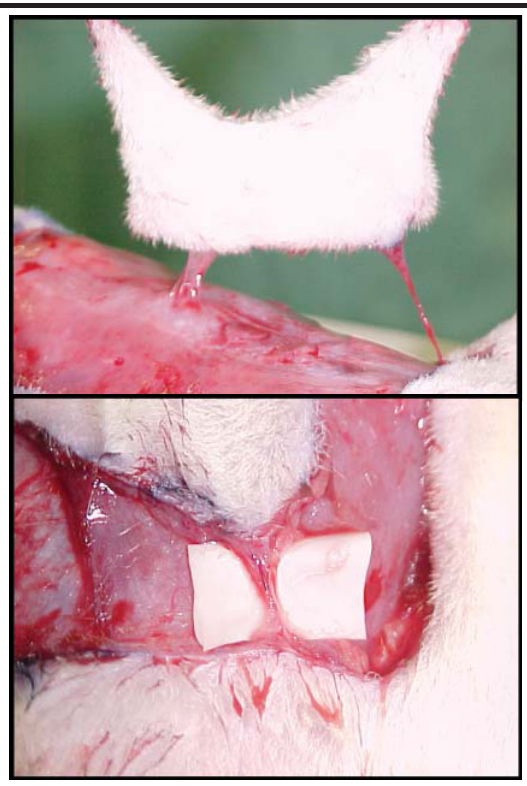
FIGURE 4 - Zone demarcation over the fl ap. Zone I, over the vascular pedicle; Zone II, lateral to midline; Zone III, lateral to Zone I; Zone IV, lateral to Zone